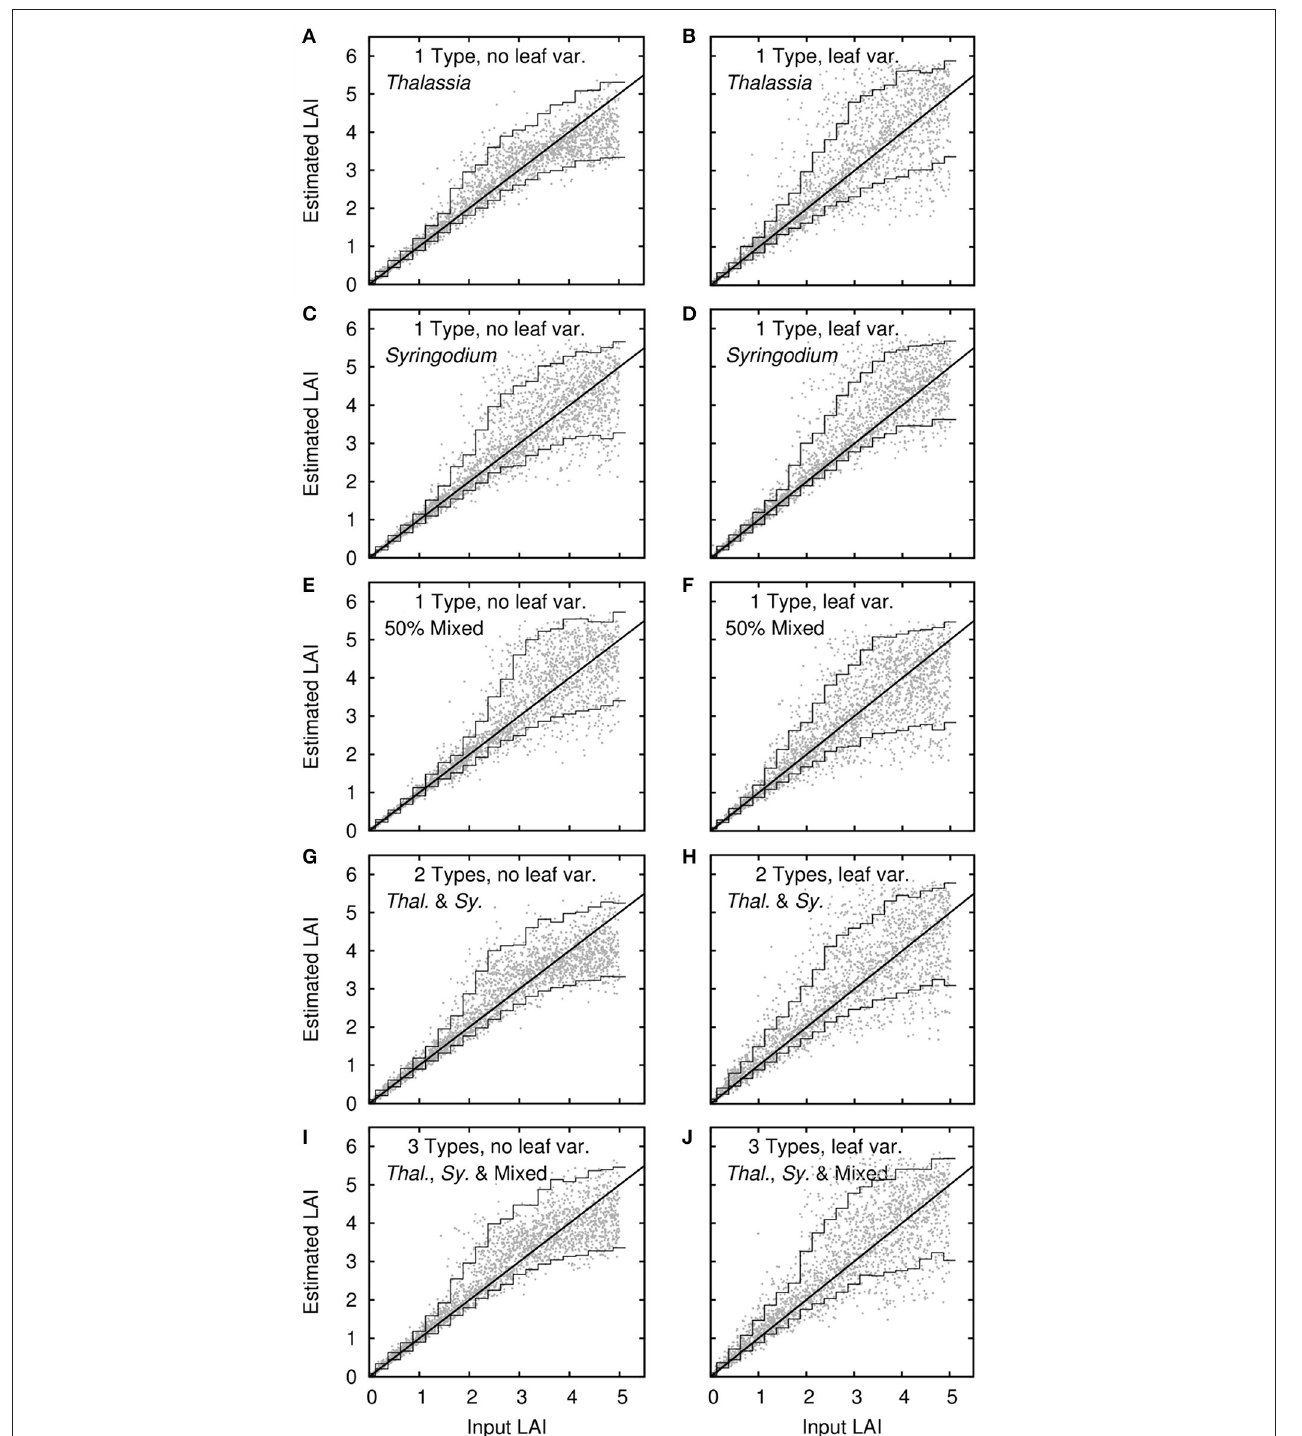
FIGURE 8 | Sensitivity analysis results for leaf area index (LAI). Dots are 2,500 noise-perturbed self-inversion results, lines are mean 90% confidence intervals binned in steps of 0.25 in LAI. Treatments are (A–F) single benthic types of Thalassia , Syringodium and 50% mixed canopies, plus (G–J) models with multiple bottom types. Right and left columns are with and without variation in leaf